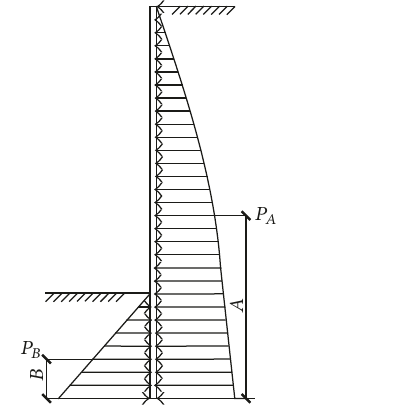
Figure 10: Schematic of the stability analysis of the pile plate retaining wall.